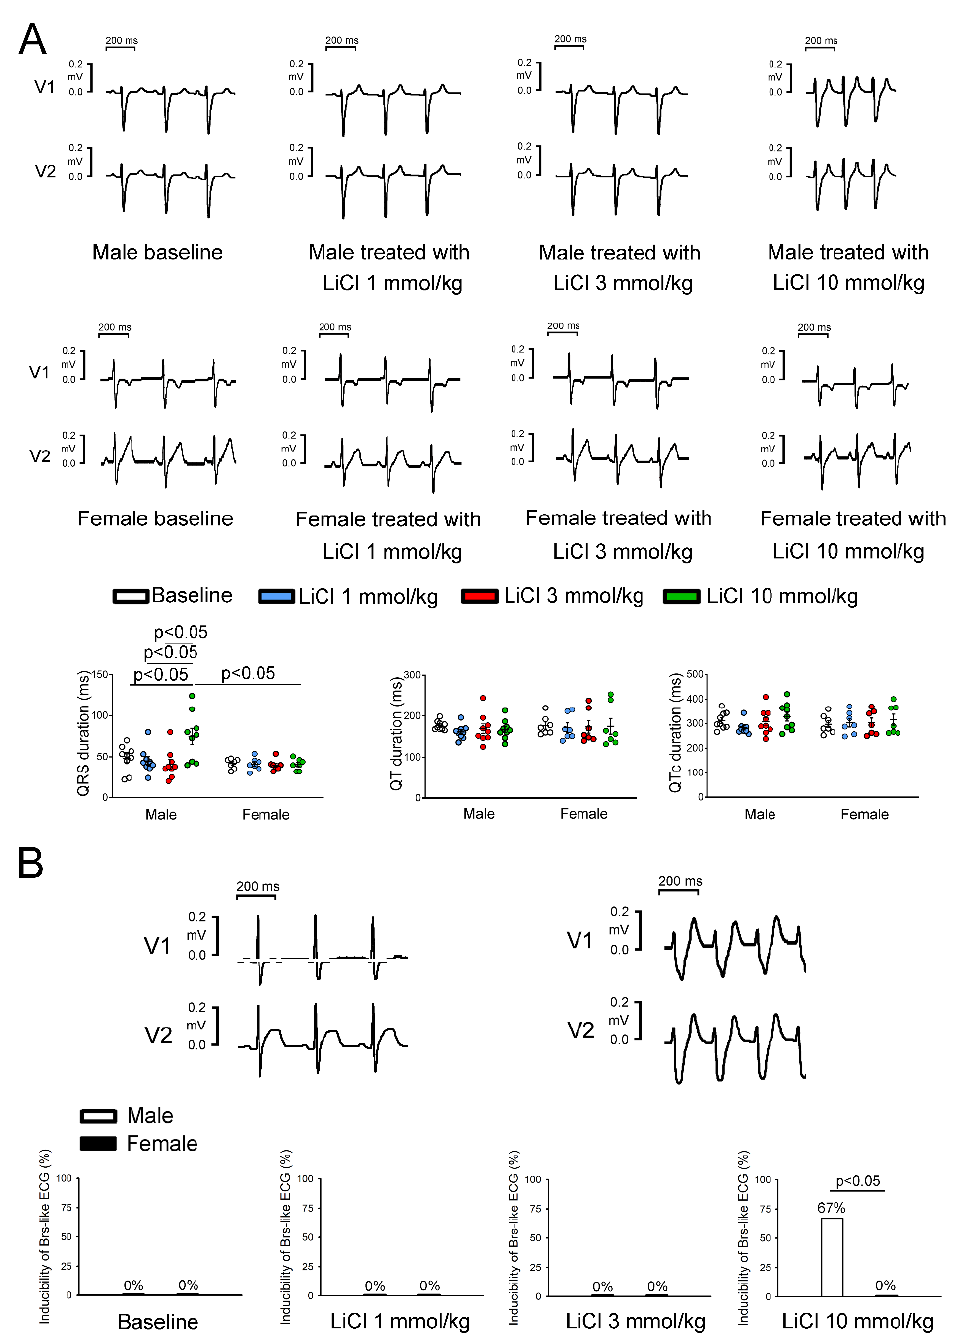
Figure 2. Electrocardiographic changes in lithium chloride (LiCl)-treated rabbits by sex. ( A ) Repre- sentative electrocardiographic tracings and average data of the QRS duration, QT interval, and cor- rected QT (QTc) interval from the male ( n = 9) and female ( n = 7) rabbits treated with 1, 3, and 10 mmol/kg of LiCl. ( B ) Representative electrocardiographic morphology during baseline and under 10 mmol/kg of LiCl. Listed on the bottom is the inducibility of Brugada-pattern electrocardiographic changes in male rabbits treated with 1, 3, and 10 mmol/kg of LiCl.